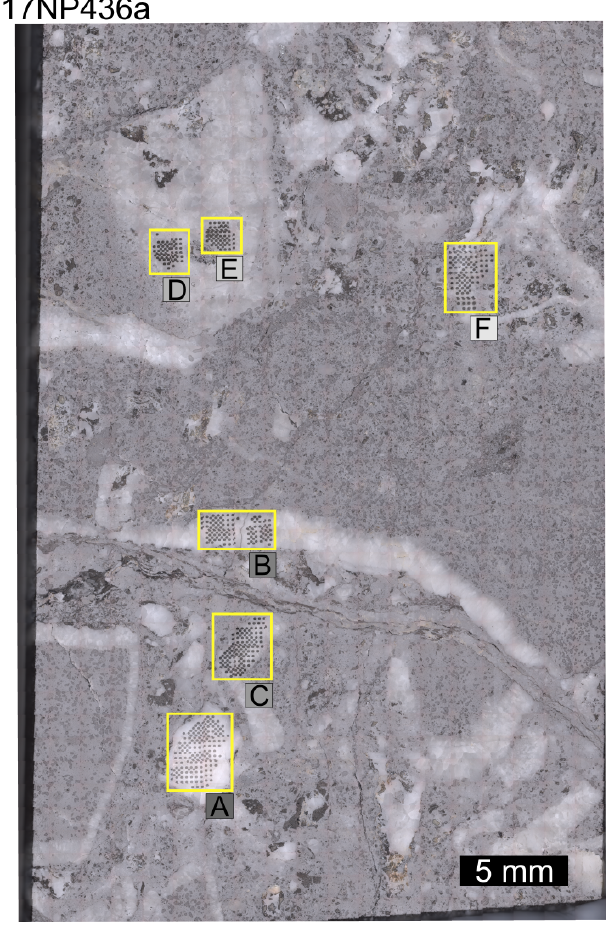
Figure A1. Reflected light image of sample 17NP436a with marked ablation areas. Letter, attached to the yellow boxes, appended to the sample name, labels the ablation areas. Colors of label boxes are consistent with colors of in-text